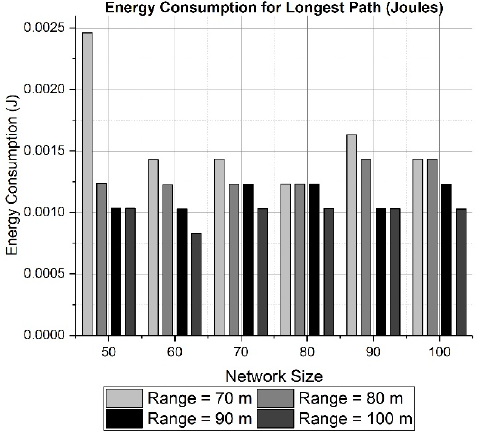
Figure 11. Energy consumption for the longest path (200 × 200 × 200 m).